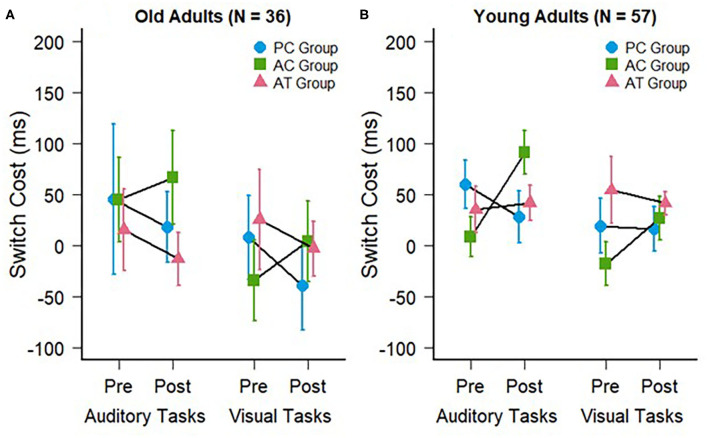
Switch costs during auditory (trained) and visual (untrained) task switching at pre- and post-test for (A) the old adults of the present study and (B) the young adults of a previous study (Kattner et al., 2019). Error bars depict standard errors of the mean.